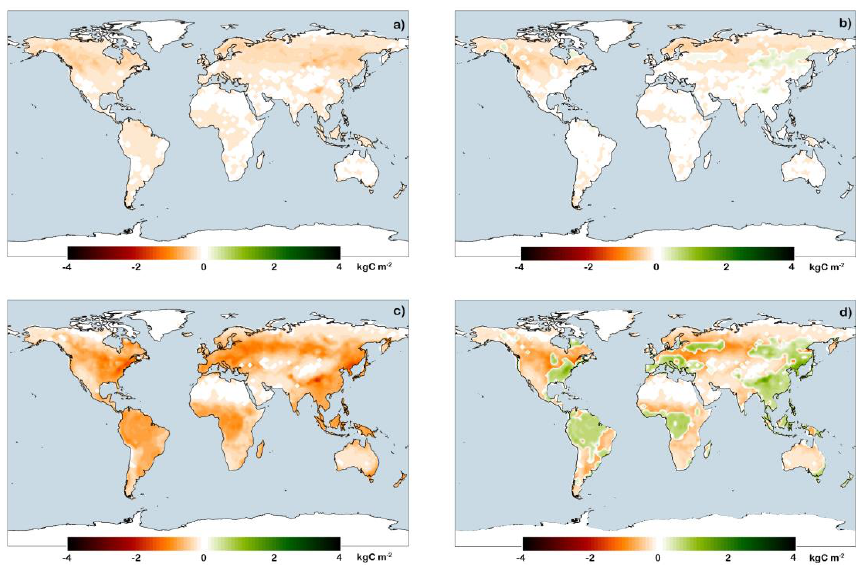
Figure 4. Difference in SOC at equilibrium between ET and ES ( ET − ES ) (a) , between EP and ES ( EP − ES ) (c) , and the change in error in SOC predictions with respect to the observations due to the modified temperature sensitivity ( | OBS − ES | ) − ( | OBS − ET | ) (b) , and due to adding priming ( | OBS − ES |−| OBS − EP | ) (d) . Positive values in (b) and (d) indicate the modification to the model’s improved prediction of SOC compared to the observations.